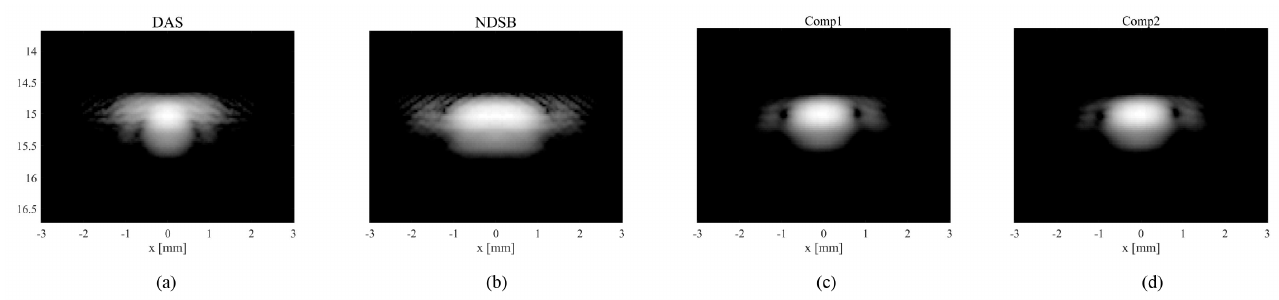
Figure 4. B-mode images of a point target. ( a ) DAS image ( b ) NDSB image ( c ) Comp1 image ( d ) Comp2 image.